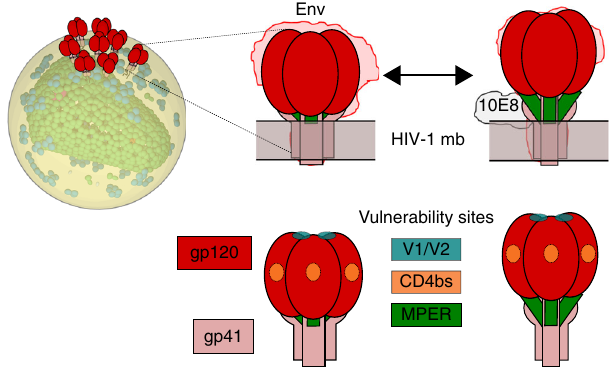
Fig. 1 Model for MPER accessibility within native Env complexes based on Cryo-EM reconstructions 15 . Top: Contours derived from detergent- solubilized Env trimers, without (left) or with 10E8 bound (right), have been docked into a viral lipid bilayer. A putative transition between these two states would result in exposure of the MPER helix in native Env (green). Bottom: cartoons to designate in the previous models the different trimer components, and positions of the neutralizing epitopes for bnAbs used